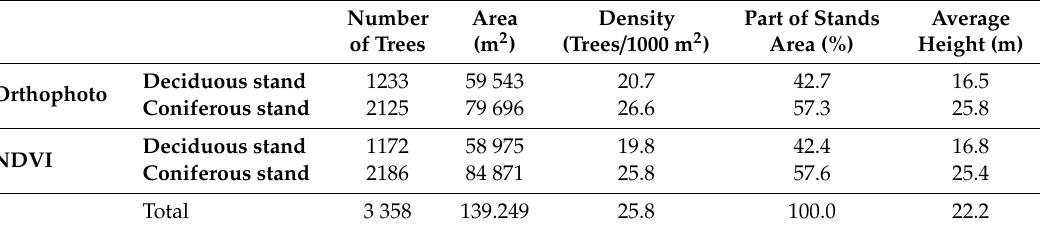
Table 1. Orthophoto and NDVI (normalized di ff erence vegetation index) image stand classification into deciduous and coniferous trees.